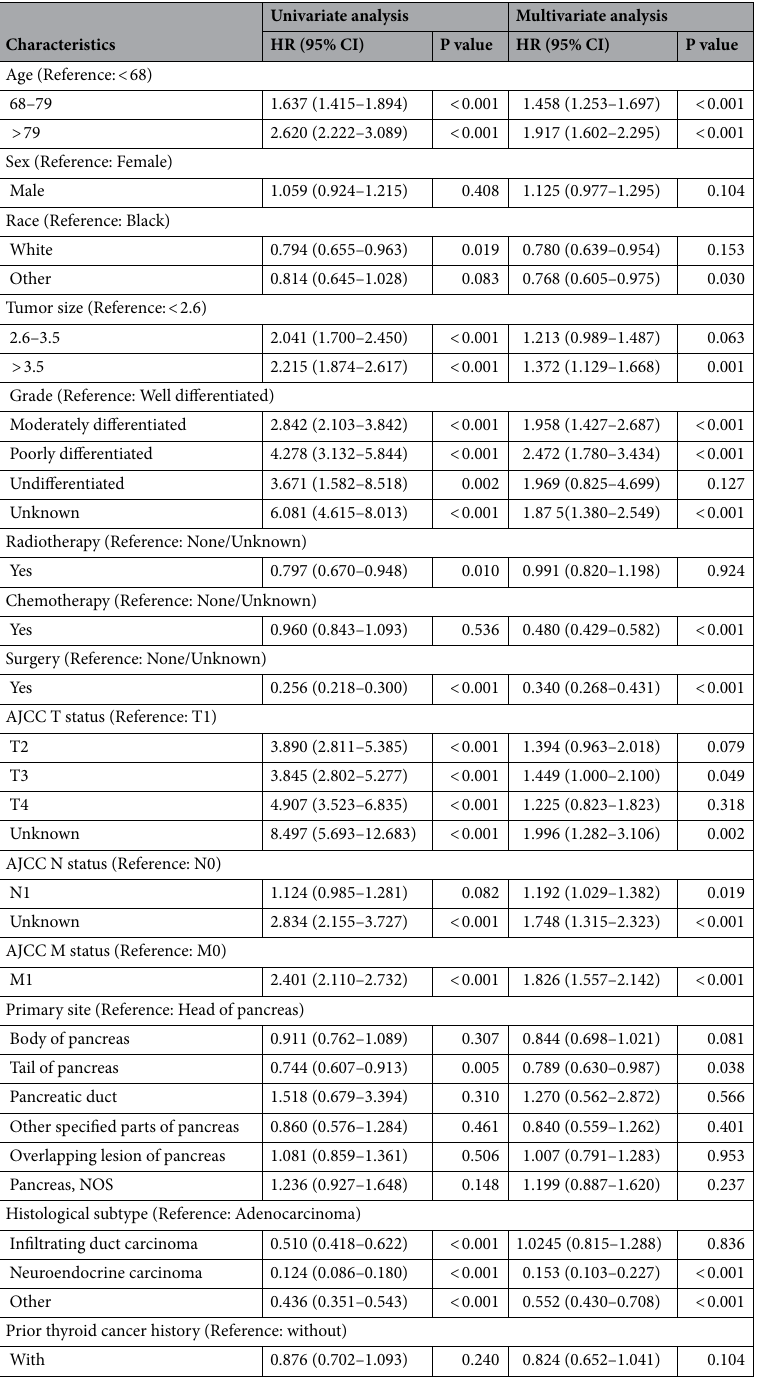
Table 2. Univariate and multivariate Cox survival analyes of OS in PC patients. OS overall survival, AJCC American Joint Commission on Cancer(7th), SEER the surveillance, epidemiology, and end results, HR hazard ratio, CI confidence